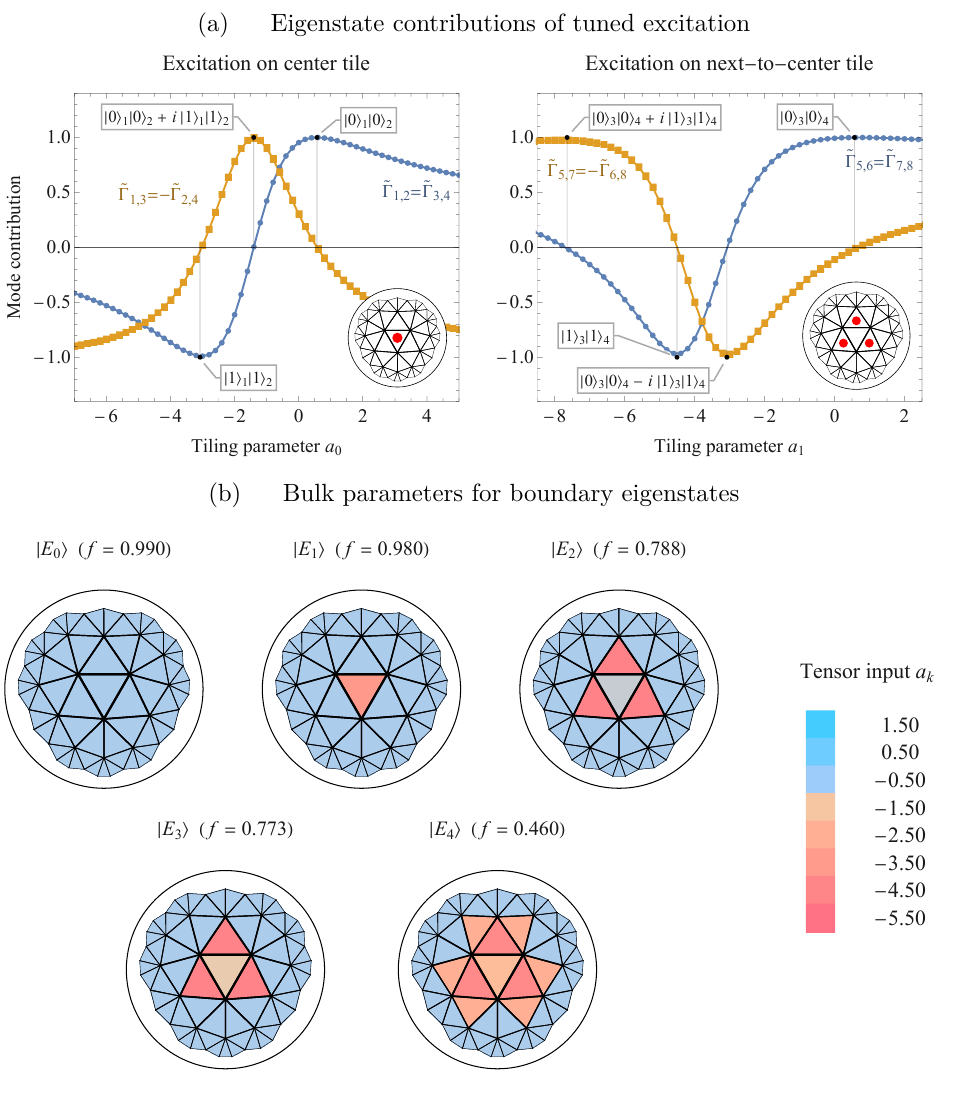
Figure 15 . (a) Dependence of covariance matrix entries ˜Γ j,k in the eigenbasis of H QI under variation of the tiling parameter on the central tile (left) or its neighboring tiles (right) in the { 3 , 7 } tiling. The modified tiles are marked as red dots in the inset. The boundary consists of N = 33 sites ( n = 2 inflation steps). (b) The bulk input corresponding to various excited states color-coded for each tile. The state fidelity f with respect to the exact excited state of H MDI is also